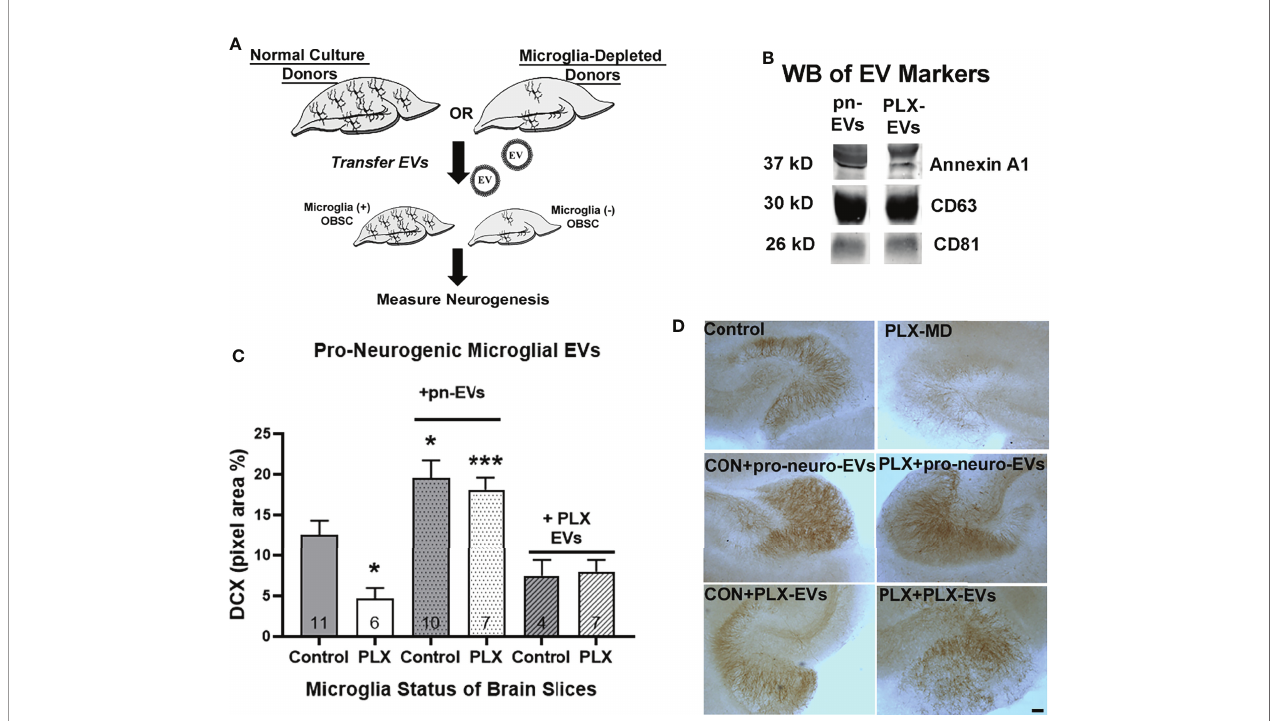
FIGURE 2 | EVs from microglia-containing cultures are pro-neurogenic. (A) Experimental design for EV transfer experiments from normal microglia-containing and PLX microglia-depleted OBSCs. EVs from each donor condition were transferred to either microglia-containing (Control) or microglia-depleted (PLX) OBSC recipients. (B) Western blot analysis shows expression of EV markers Annexin A1, CD63 and CD81 in pn-EVs and PLX-EVs. (C) Quanti fi cation of treatment effect on DCX immunostaining (One-way ANOVA, F 5,39 = 9.705, p < 0.0001). Microglial depletion with PLX-3397 (1µM, 10 days) caused a 62% reduction in DCX in the dentate region of the OBSC (* p < 0.05 vs. control, Sidak ’ s post-test). EVs from control OBSC (pn-EVs) increased basal levels of DCX by 55% (gray bar with dots, * p < 0.05 vs. Control, Sidak ’ s post-test) and increased DCX in microglia-depleted recipient OBSCs by 290% (white bar with dots, *** p < 0.001 vs. PLX alone, Sidak ’ s post- test). EVs from microglia-depleted OBSC donors (PLX-EVs), however, did not signi fi cantly change DCX levels in control ( p= 0.43 vs. control alone, Sidak ’ s post-test) or microglia-depleted OBSC slices ( p= 0.78, vs. PLX alone, Sidak ’ s post-test) N for each group is included within each bar. (D) Representative images of DCX IHC in OBSC treatment groups. Scale bar 100